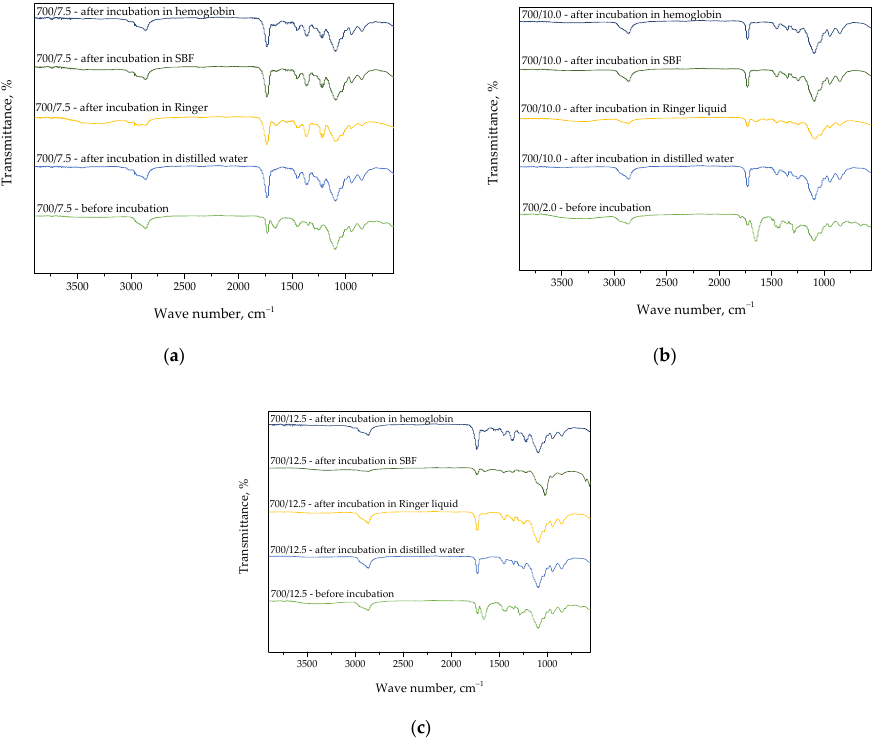
Figure 17. FT-IR spectra showing the impact of the incubation on the structure of sample 700/7.5 ( a ), 700/10.0 ( b ), and 700/12.5 ( c ).